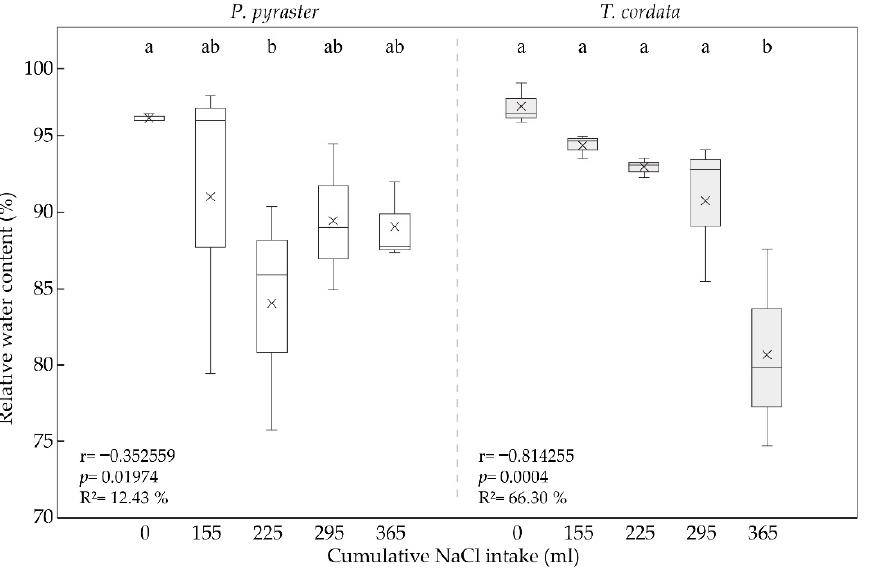
Figure 4. Box plot for the relative water content (RWC) for seedlings of P. pyraster and T. cordata measured at the beginning of the experiment (0 mL) and during the experiment when treated with 100 mM NaCl solution. Significant differences between measurements ( p < 0.05) are indicated by different